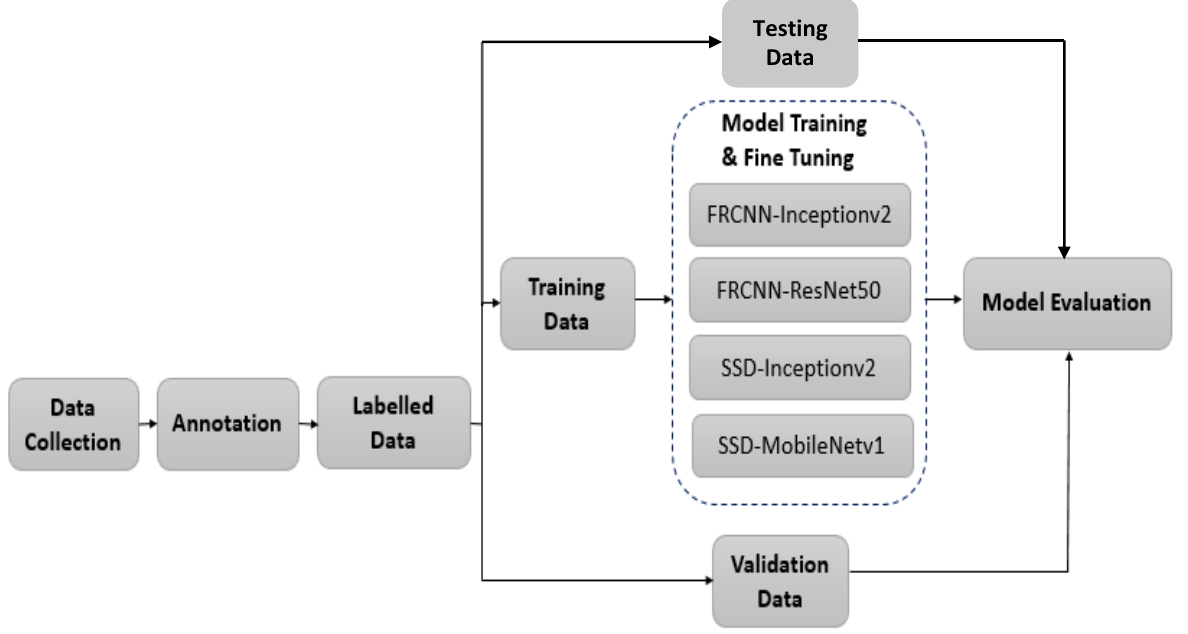
Figure 2. Proposed approach to compare various deep learning-based human detection models. Note: FRCNN stands for Faster R-CNN.